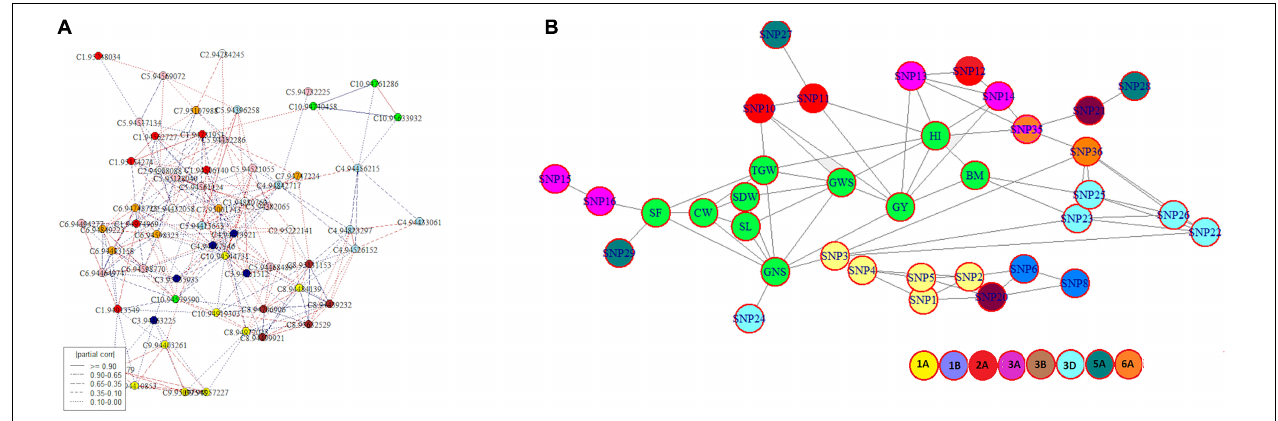
FIGURE 4 | (A) Intra- and inter-chromosomal conditional interaction network among 77 significant SNP markers across bread wheat genome where each colour represents a different chromosome and (B) a genotype-phenotype network showing interaction among traits and associated SNPs where traits are highlighted in green and other colours designates different